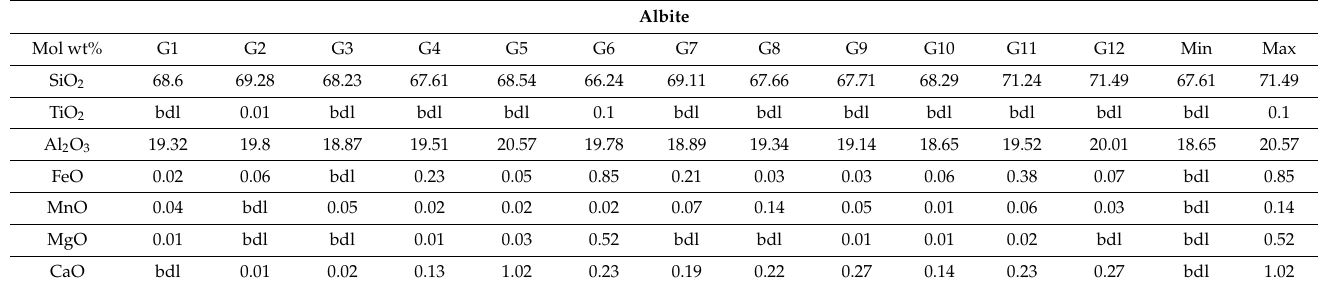
Table 2. Mineral chemistry of feldspar in the polymetallic uranium deposit of